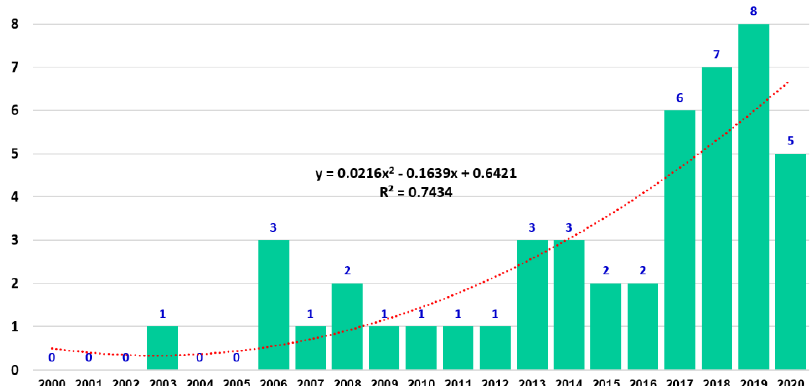
Figure 4. Documents published from 2000 to 2020.